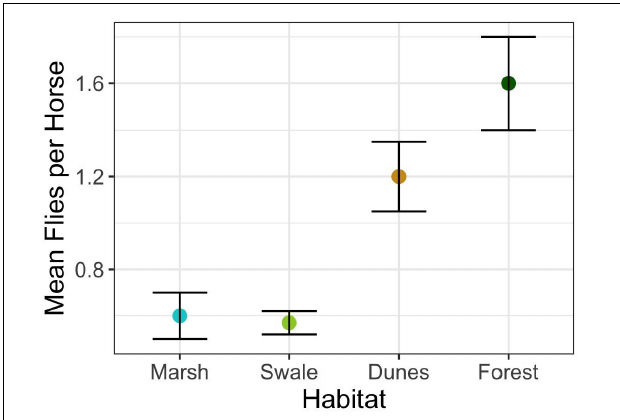
FIGURE 4 | Mean and standard error of average fly landings per horse during the summer for the four major Shackleford Banks habitats ( F 3 , 663 = 25.3; p < 0.0001).